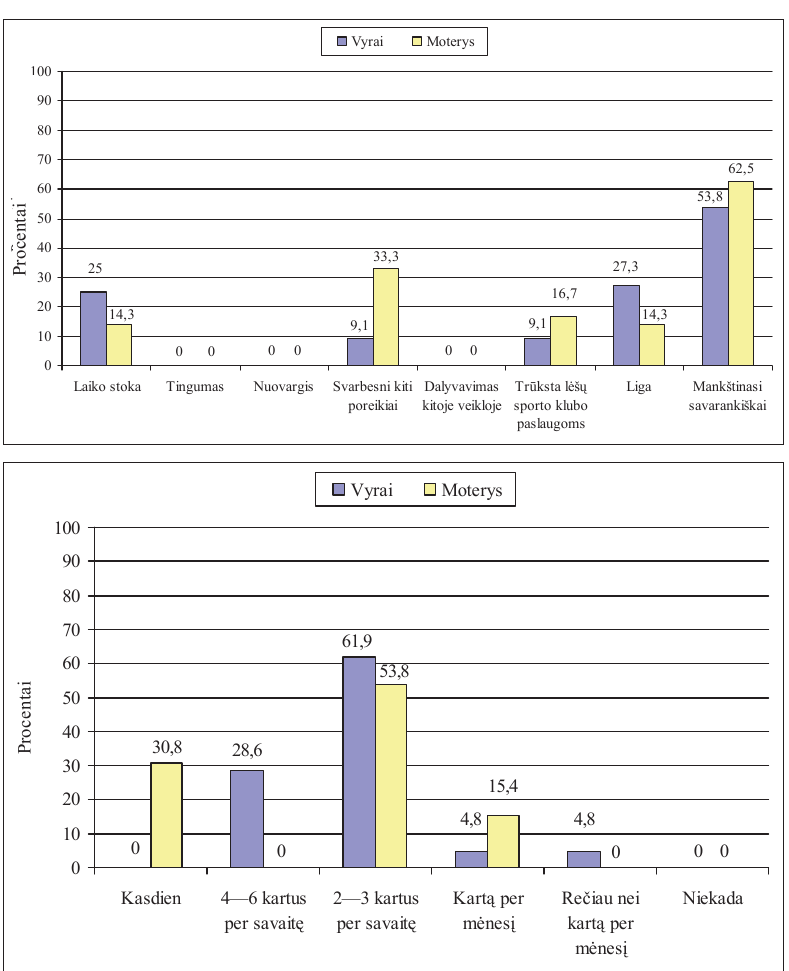
Pastaba. χ 2 = 11,9; l.l. = 4; p <